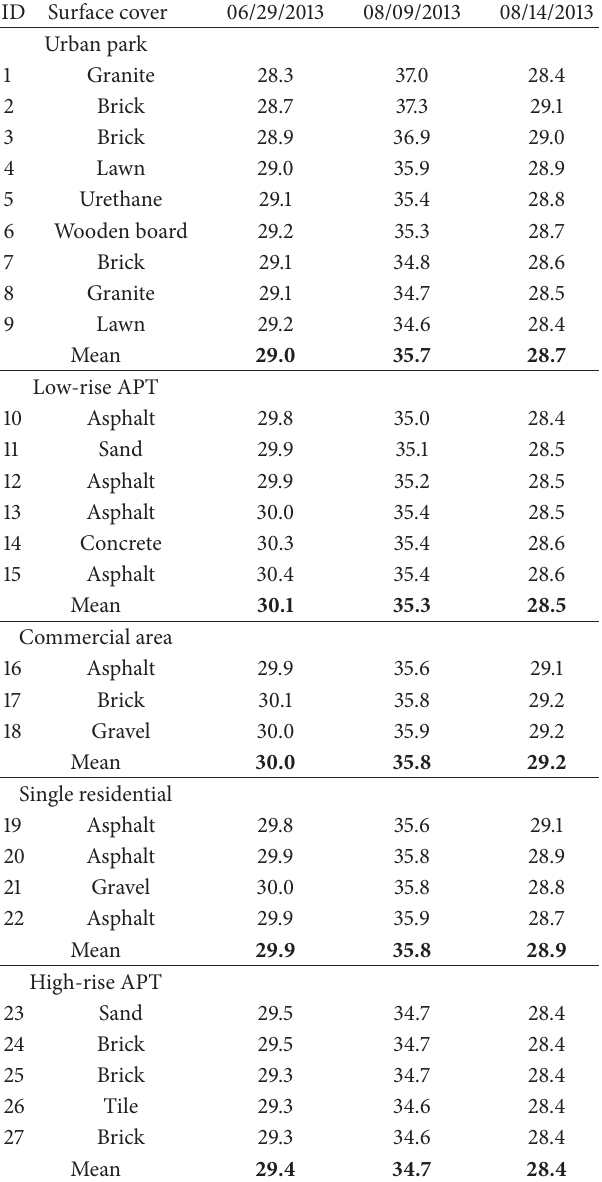
Table 4: Field temperature measurement ( ∘